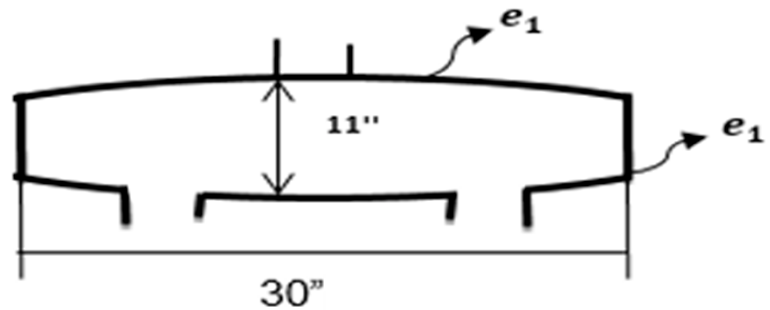
Figure 9. Dome formed by elliptical covers to store hot water and steam.